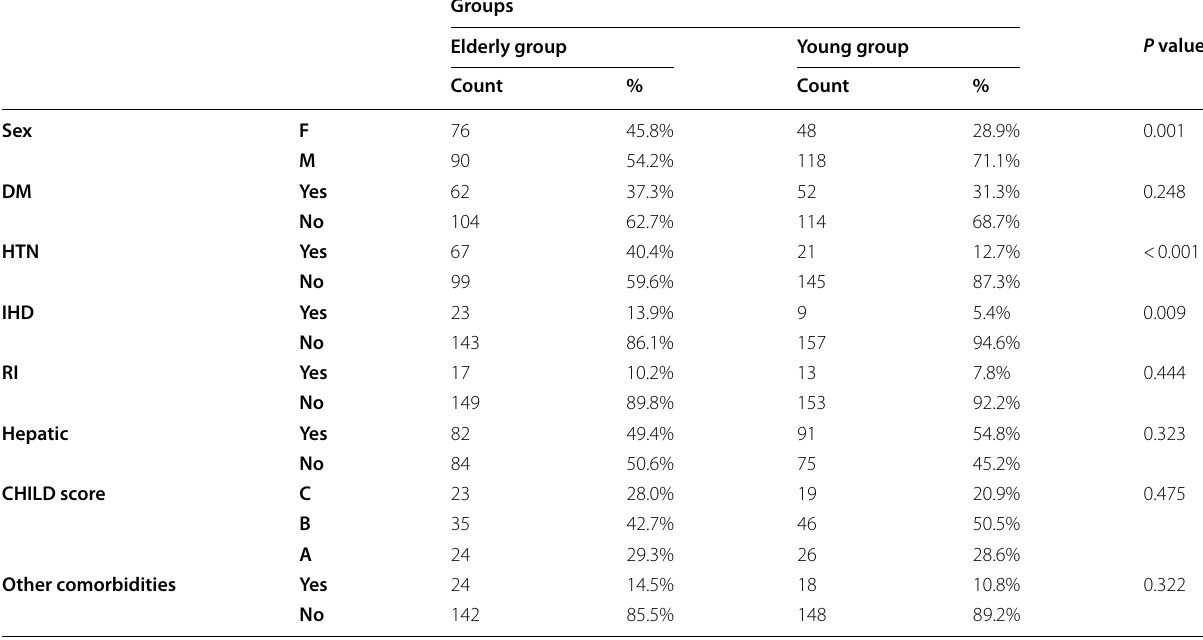
Table 2 Comparing both groups regarding gender and medical condition